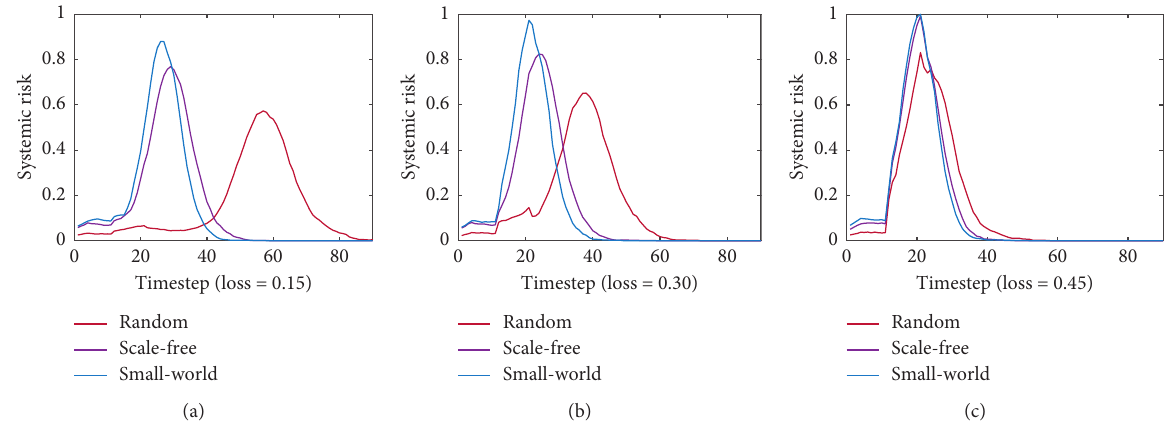
Figure 9: Evolution results of the diverse interbank networks suffer a loss at step